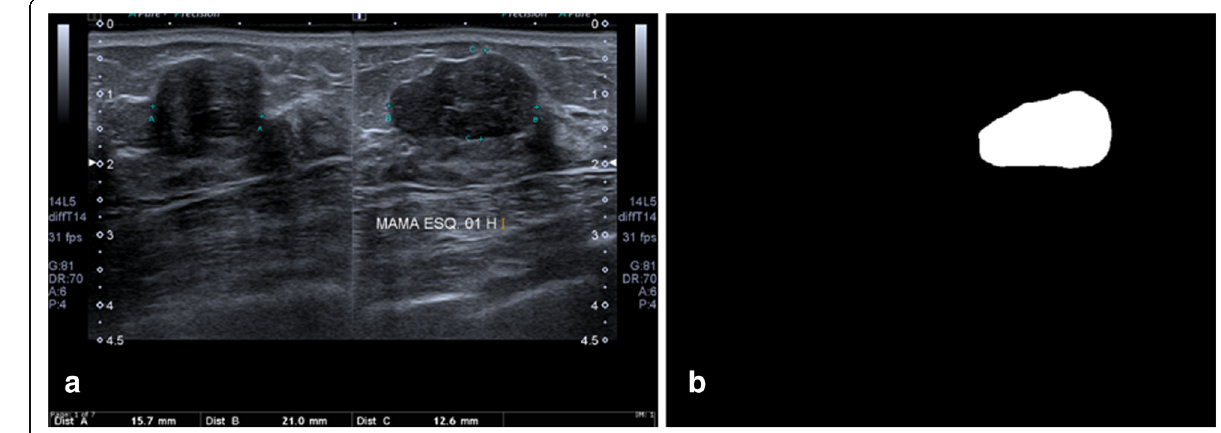
Fig. 4 Example of segmentation of a fibroadenoma. Original ( a ) and segmented ( b ) images (to classify the lesions, the segmented image was along the plane best representing the mass that was used, in this case, the long